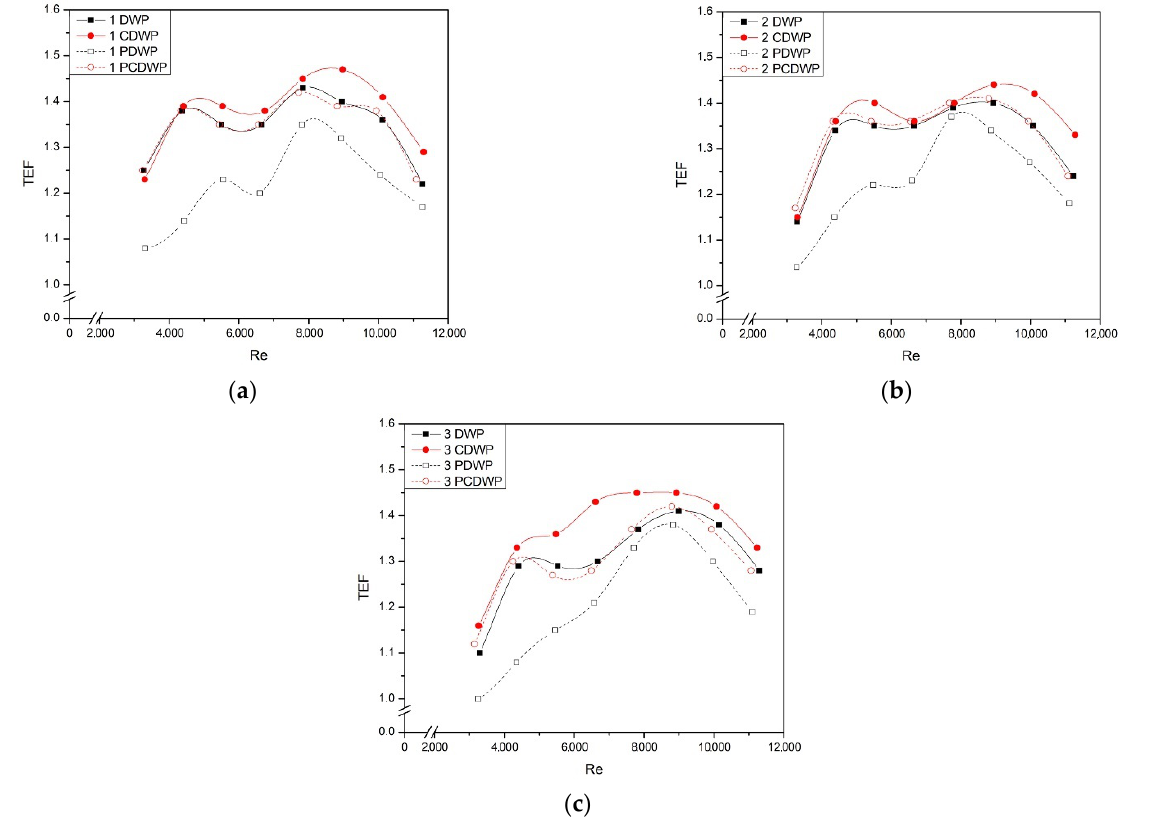
Figure 6. TEF for various VGs with/without holes against Reynolds number for the use of various numbers of VG pairs. ( a ) One pair of VG, ( b ) Two pairs of VG, and ( c ) Three pairs of VG.